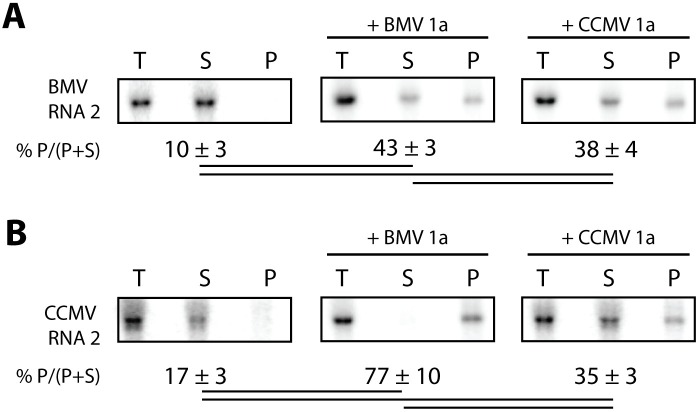
CCMV 1a recruits RNA2 templates to membranes.(A) Cells expressing BMV or CCMV RNA2 alone or with BMV or CCMV 1a as indicated were lysed and centrifuged to pellet cellular membranes prior to RNA isolation. Accumulation of positive-strand RNA2 was assayed by northern blotting from total lysate (T), supernatant (S), and pellet (P) fractions. The relative percentage of RNA in the pellet fraction is indicated below each gel as the average and standard deviation quantified from three fractionations. A line connecting two numbers indicates a statistically significant difference (p<0.05).